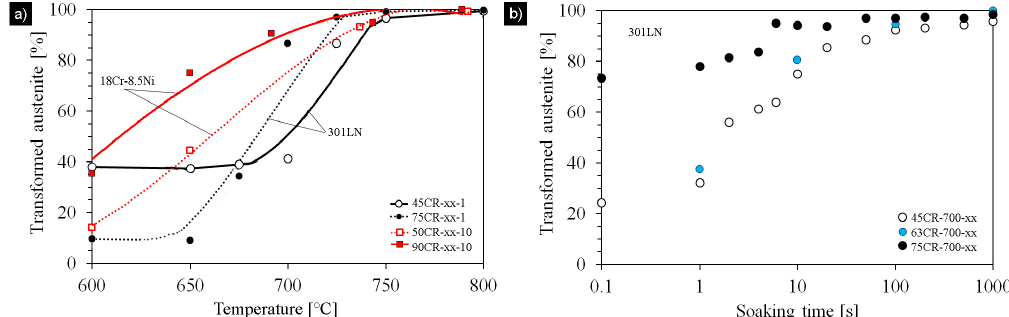
Figure 4. The effect of prior cold rolling reduction and annealing parameters on the reversion kinetics: Annealing temperature ( a ) and soaking time at 700 °C ( b ). Data collected from References [23,40] ( a ) and [23,26,88] ( b ). Legend: Reduction (%CR), annealing temperature (°C) and time (s).